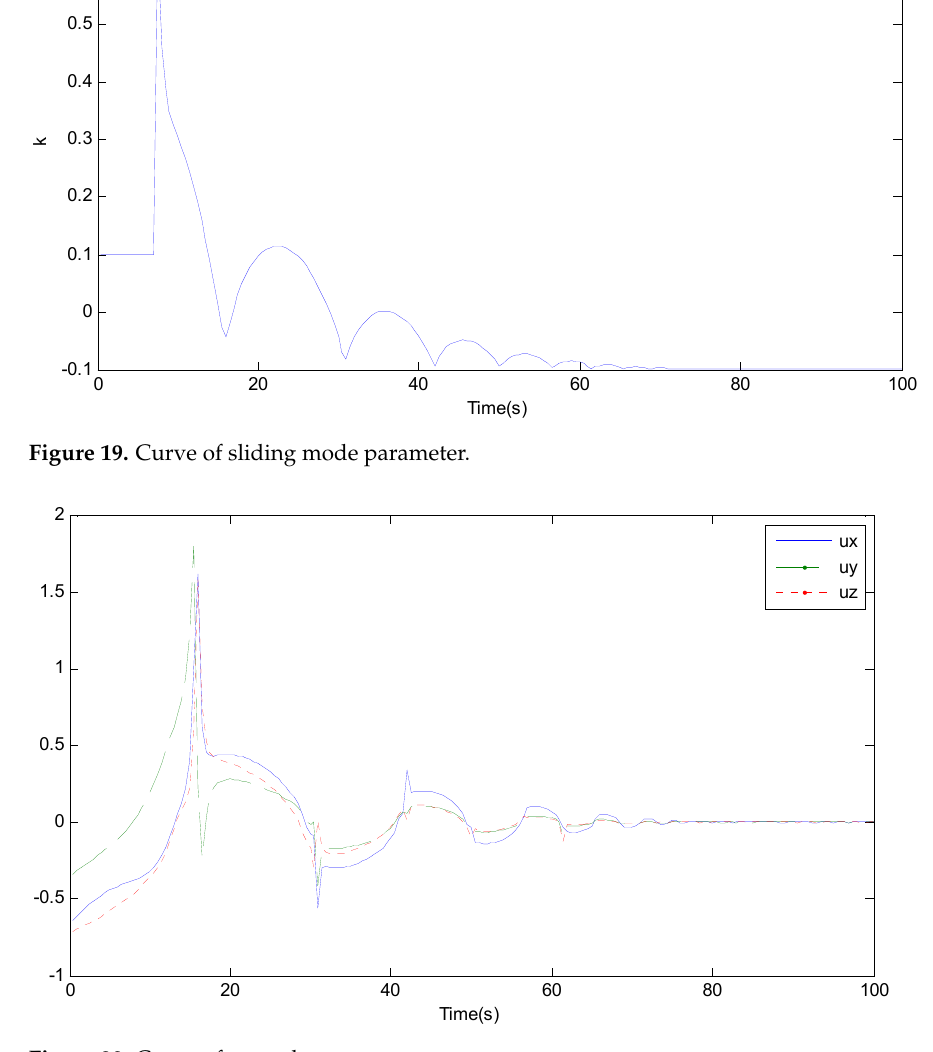
Figure 20. Curve of control torque.